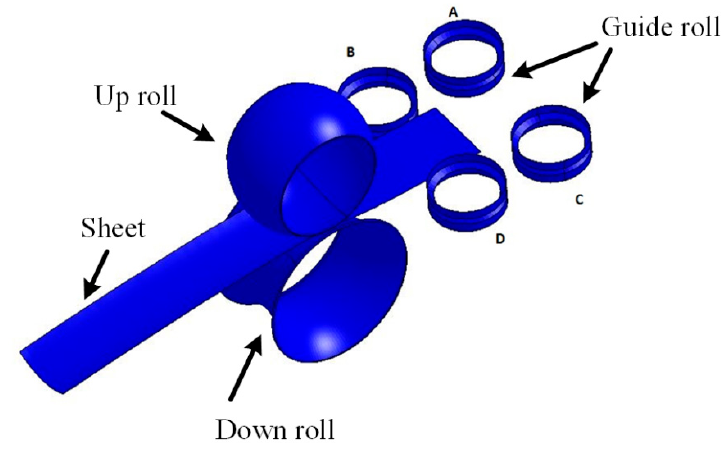
Figure 11. A model of the finite element of roll forming.